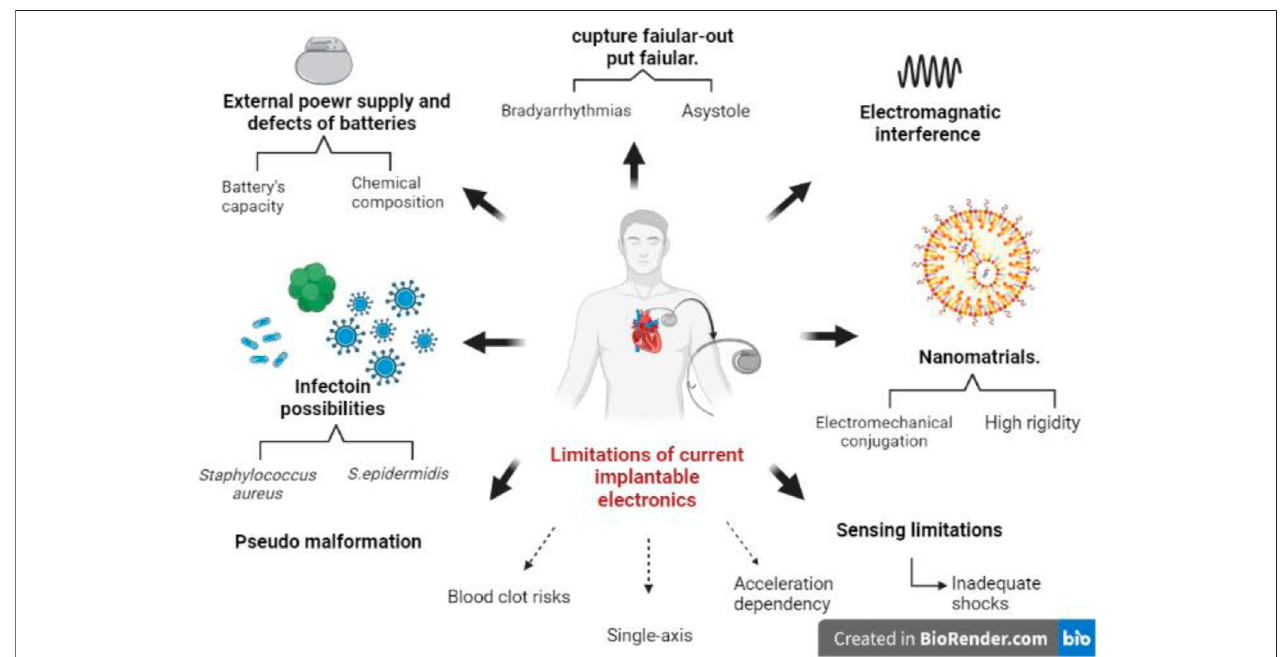
FIGURE 3 | The most effective limitations of implantable electronics devices (pacemakers). Starting with the power supply and the longevity of batteries. Current shunting may also defect the pulse generator. Pathological infections of Staphylococcus aureus or S. epidermidis are a limitation faced by patients who reused their pacemakers.Additional concerns associatedwithpacingarecapture failure thatmaycomplicatethesituations withbradyarrhythmiasand asystole. Sensinglimitationis a challenge with a possible consequence of inadequately rapid shocks. Electromagnetic interference is related to cardiac pacemaker complications as well. Nanomaterials used in implantable electronic devices could cause electromechanical conjugation, and high rigidity issues resulted in low electrical output. Additional limitations include blood clot risks, single axis, unadaptable size and shape of the pacemaker, and acceleration